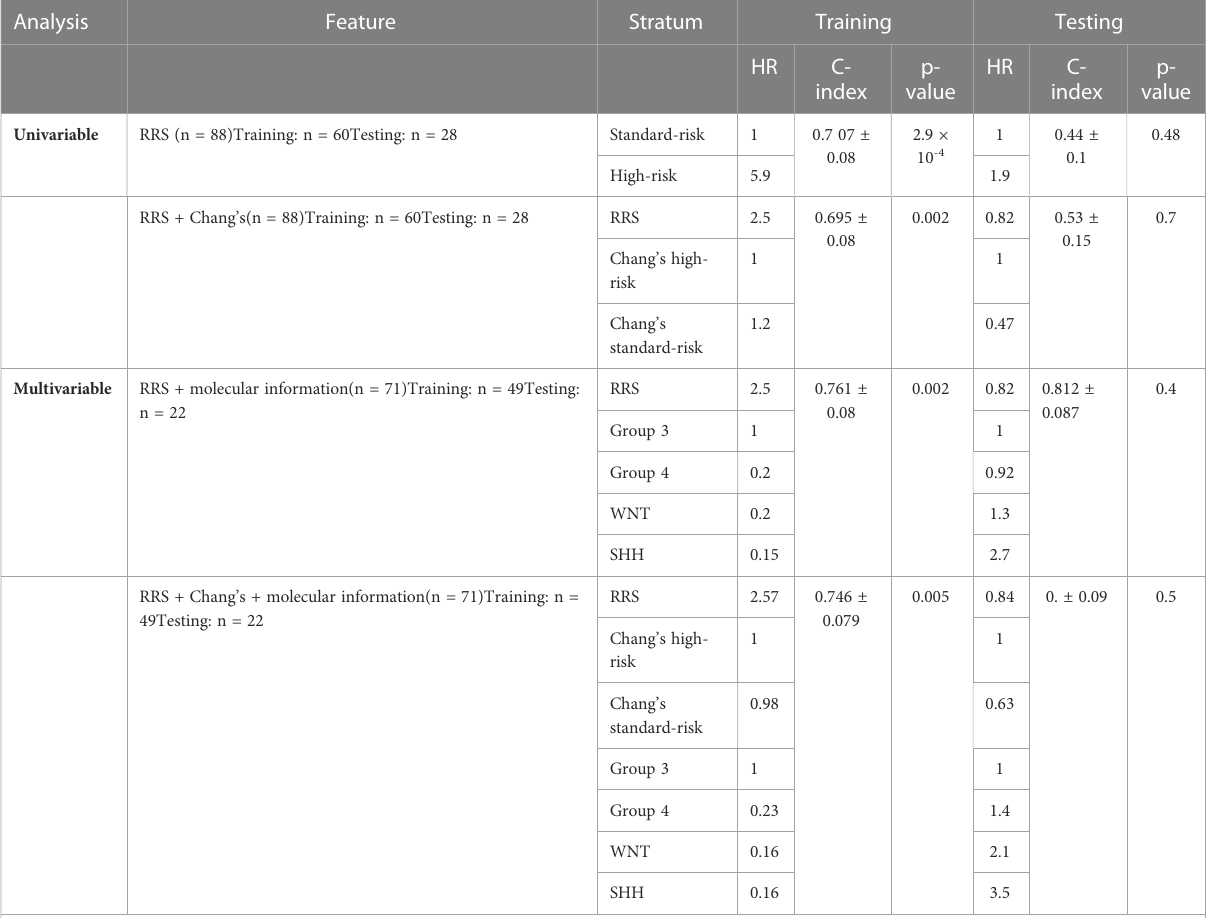
TABLE 4 p-values, concordance indices, and hazard ratios for the survival experiments conducted using our radiomic risk score (RRS), in both univariate and multivariate settings.